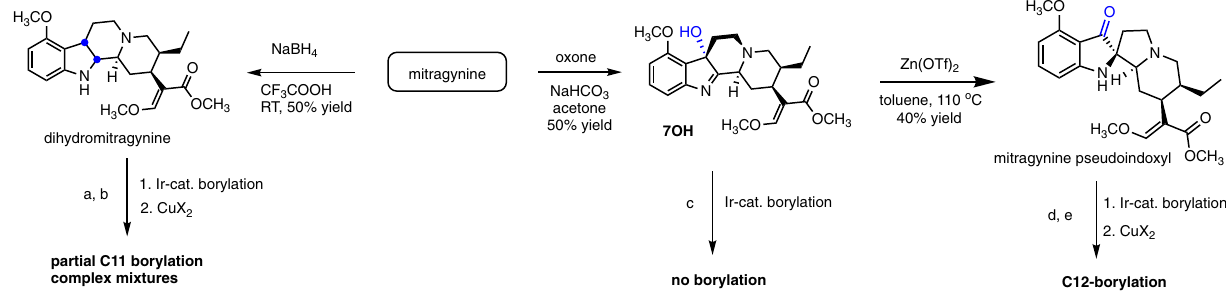
Fig. 3 Catalytic borylation of MG analogs with reduced, oxidized, or rearranged indole nucleus. a B 2 Pin 2 , dtbpy/Me 4 -phen, [Ir(COD)(OMe)] 2 , 65 °C, dry heptane; 50% conversion to 11-boronate ester by 1 H NMR. b CuBr 2 , MeOH/H 2 O (4:1), 80 °C; using the crude borylation mixture, provided mixtures of mitragynine, 2,3-dihydromitragynine (major products, ~60% by 1 H NMR) and 11-Br-dihydromitragynine and 11-Br-MG (minor products, ~30% by 1 H